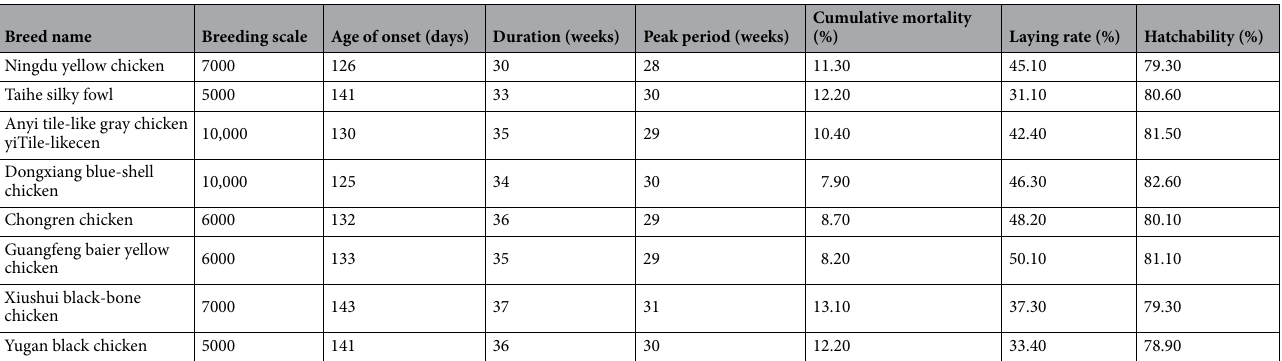
Table 4. Production data collected from the farms investigated in this study.